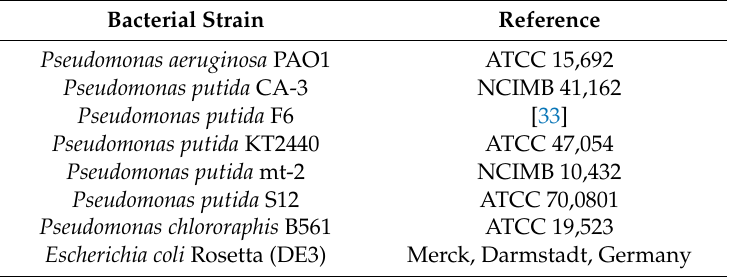
Table 3. Bacterial strains used in this study. Bacterial Strain